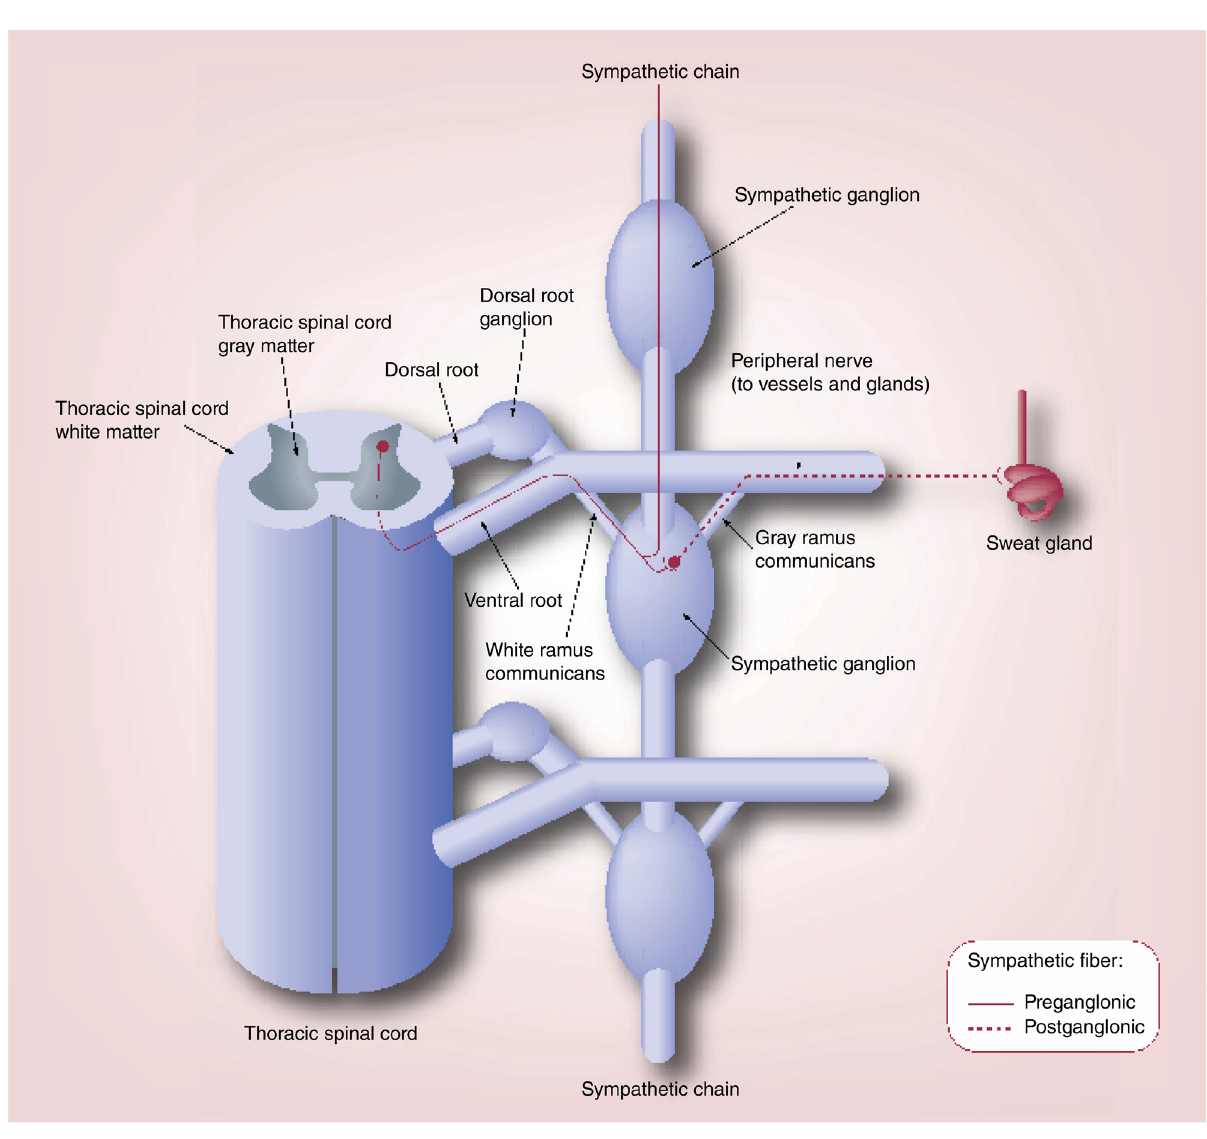
Figure 1. Anatomy of the sympathetic chain in relation to the spinal cord and sweat glands as the target organ. 16 Reprinted from Thoracic Surgery Clinics, Volume 18, Issue 2, Shargall Y, Spratt E, Zeldin RA. Hyperhidrosis: What is it and why does it occur? Pages 125–132, Copyright (2008) with permission from